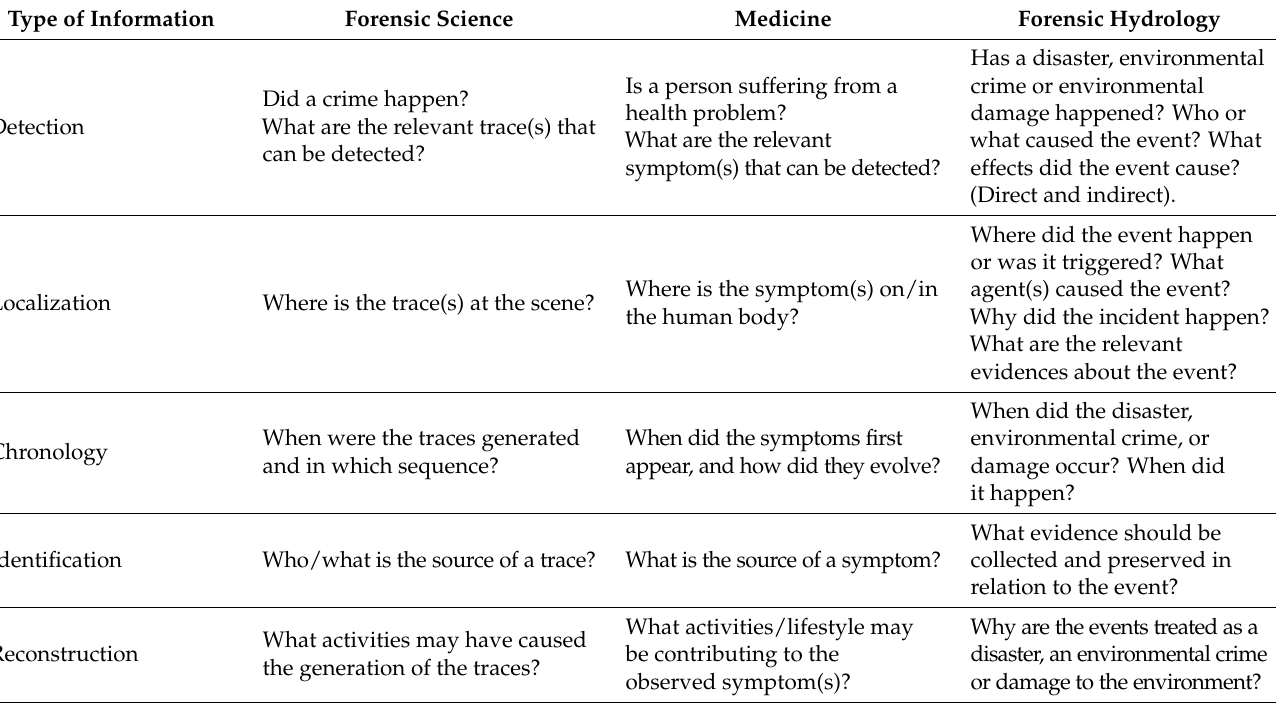
Table 2. Example of questions that can be asked in forensic science, medicine and Forensic-Hydrology (adapted from